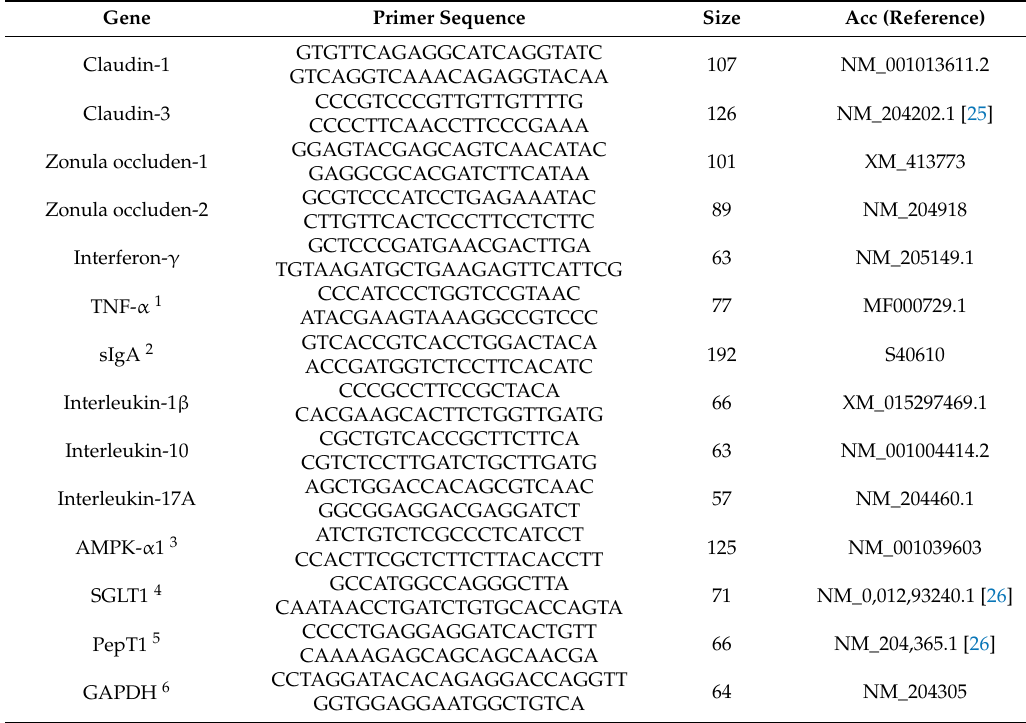
Table 2. Sequences of primer pairs used for amplification of target and reference genes. For each gene, the primer sequences for forward (F) and reverse (R) are listed (5 (cid:48) -3 (cid:48) ), the amplicon size (bp) and the NCBI Accession number (Acc) used for the primer